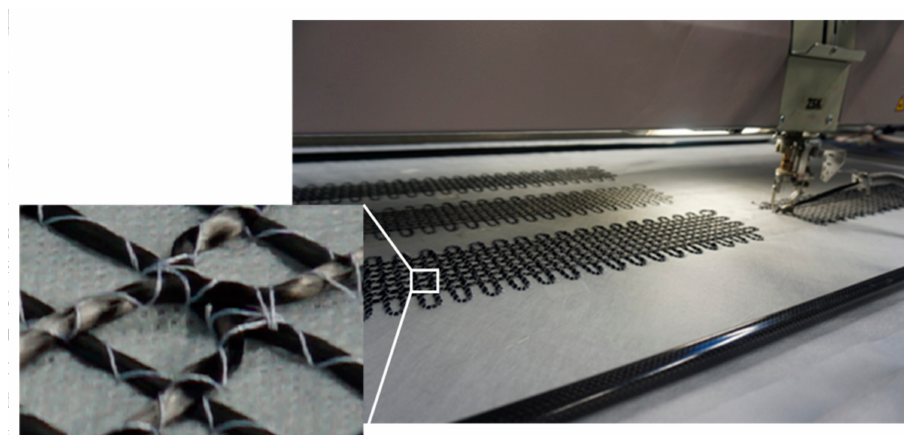
Figure 2. Embroidery machine that was used to fabricate FCSs. The machine was modified to enable simultaneous processing of carbon filaments and optical fibers to a grid-like structure on PVA nonwoven